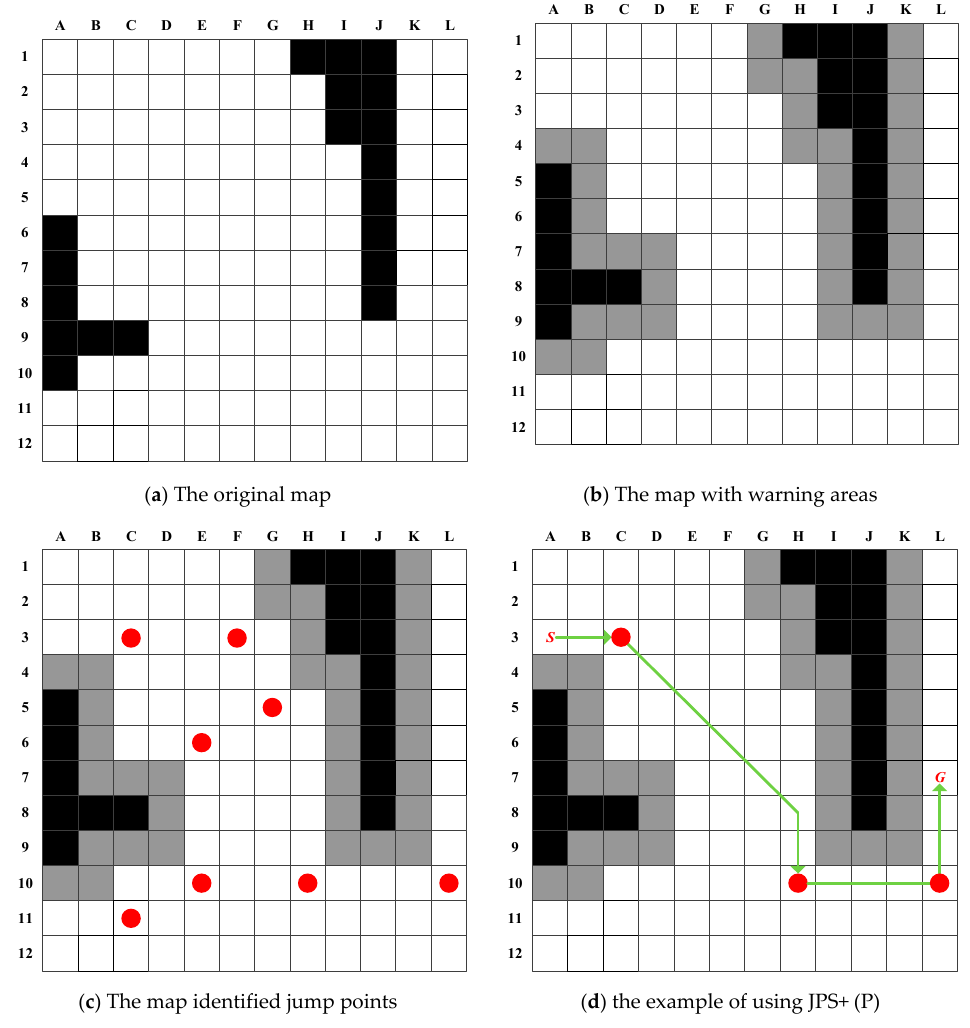
( d ) the example of using JPS+ (P) Figure 3. A graphical representation of how Jump Point Search+ (Prune) (JPS+ (P)) preprocesses an initially known grid-based map and what the paths that it plans look like. ( a ) An original map in which the white and black cells are unblocked and blocked locations, respectively. ( b ) Gray cells denote warning areas. ( c ) Jump points are marked as red. ( d ) Green lines denote an optimal path planned by JPS+ (P).